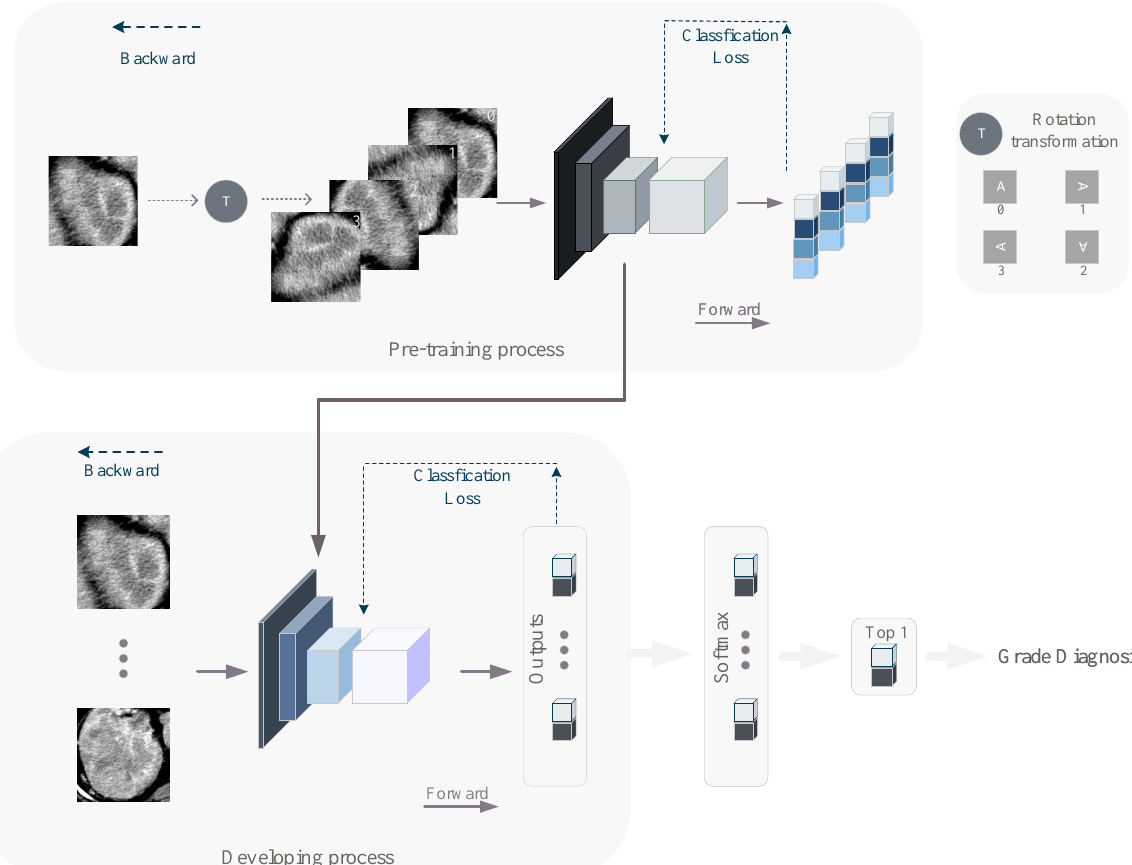
Figure 2. The overall flow of pre-training and developing. The top part of the figure shows the pre-training process. In the pre-training process, the original images are expanded into four im- ages after rotation transformation, and their labels are 0, 1, 2, and 3, representing that they are obtained by quarter-turning the original image 0, 1, 2, and 3 times, clockwise. The bottom part shows the developing process. The developing process network is initialized from the pre-training process